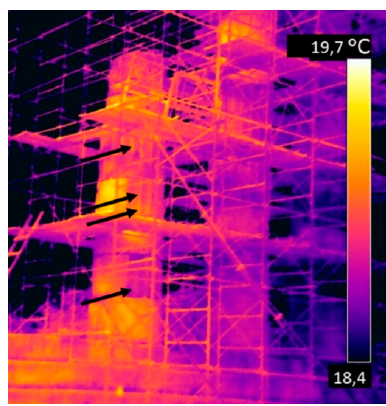
Figure 31. The edges of the shafts are noted in the thermographic images as having higher temperature.